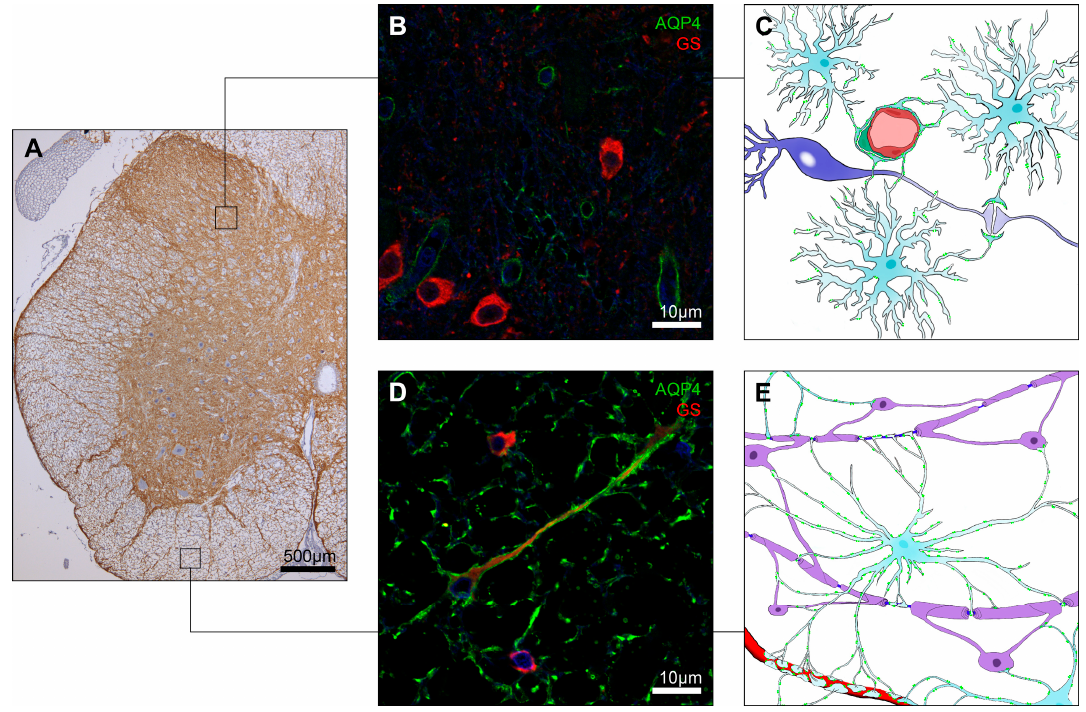
Figure 2. AQP4 expression in the spinal cord. AQP4 was abundantly expressed across the whole spinal cord with markedly higher intensity in the superficial lamina of dorsal horns, verges of ventral horns, glia limitans and surroundings of blood vessels ( A ); In the gray matter, protoplasmatic astrocytes AQP4 expression represents a polarized pattern with the highest intensity in the astrocytes foot processes encircling capillaries ( B , C ) and weaker labeling in processes belonging to the tripartite synapse ( C ); In the white matter, fibrous astrocytes AQP4 expression is observed along the cell membrane ( D , E ); Illustrations of AQP4 expression in the spinal cord ( C , E ) markings in green illustrate AQP4. The blue signal in panels B and D represents DAPI staining of the nuclei. Immunoperoxidase staining of AQP4 ( A ) and immunofluorescence images ( B , D ) are modified from Oklinski et al. [21]. AQP4, aquaporin 4; GS, glutamate synthase.